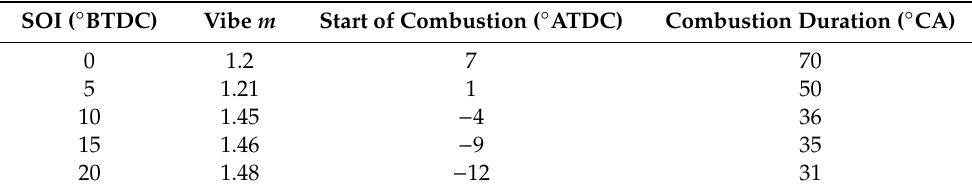
Table 6. Vibe coe ffi cient m and combustion